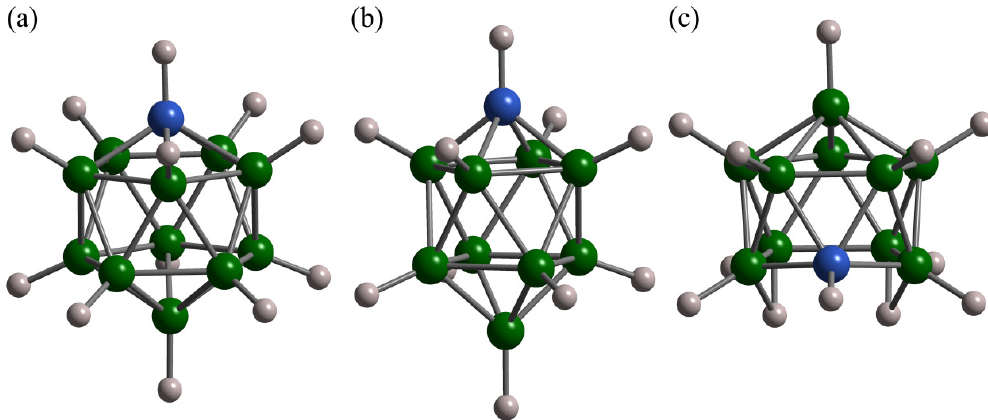
Figure 4. Schematic view of carbon-substituted hydroborate anions: ( a ) icosahedral closo -[CB 11 H 12 ] − , ( b ) bicapped-square-antiprismatic closo -[1-CB 9 H 10 ], and ( c ) nest-like nido -[7-CB 10 H 13 ] − . Green spheres: B atoms, blue spheres: C atoms, and gray spheres: H atoms.